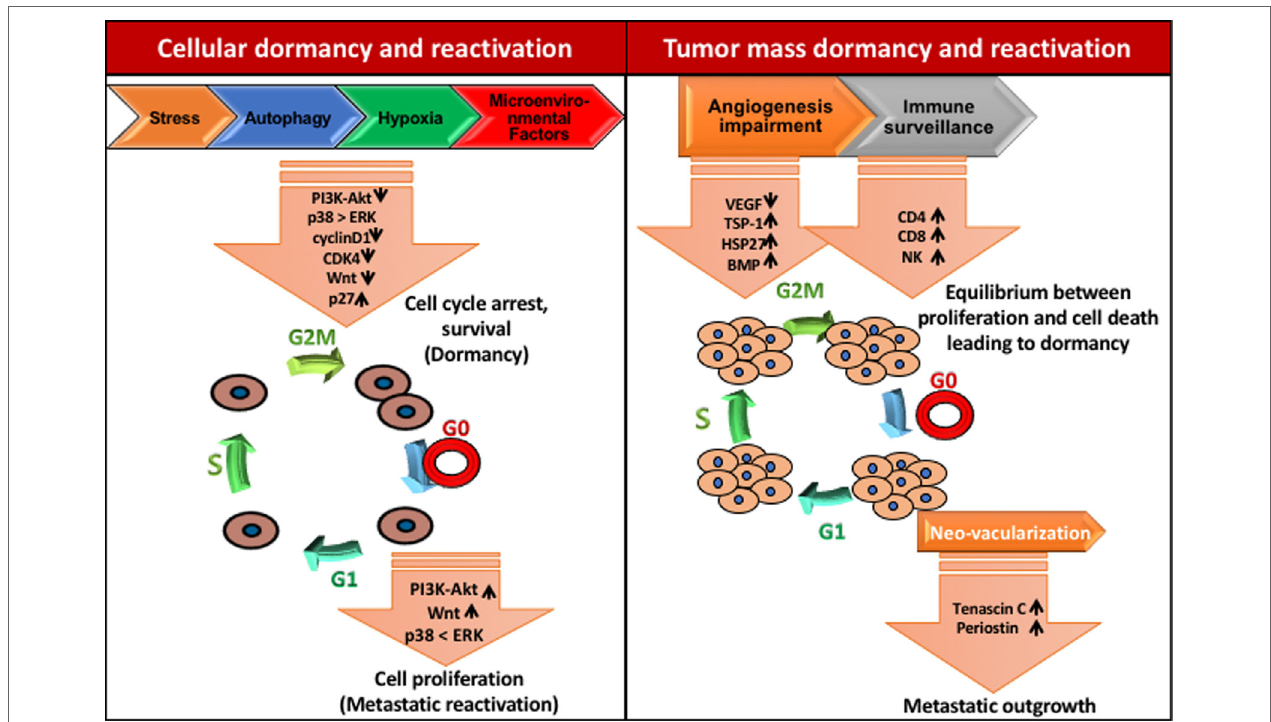
FiGURe 3 | Mechanisms of tumor dormancy. Solitary cell dormancy (cellular dormancy, left) is caused by cell cycle arrest and induction of survival mediated by various signaling cascades including downregulation of PI3K-Akt, ERK, and Wnt signaling and upregulation of p38 MAPK signaling. Tumor mass dormancy (right) is a result of the balance between proliferation and cell death due to less blood supply and immune